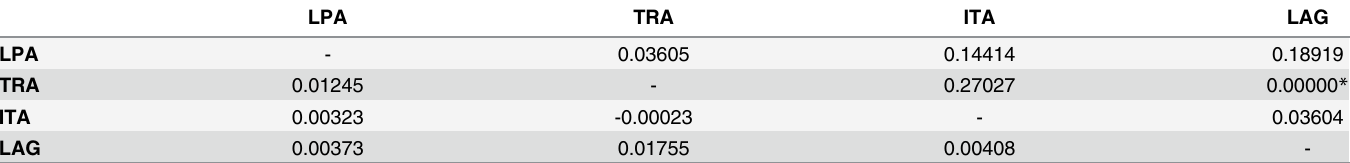
Table 6. Pairwise F ST values (below diagonal) and p -values (above diagonal) between locations.